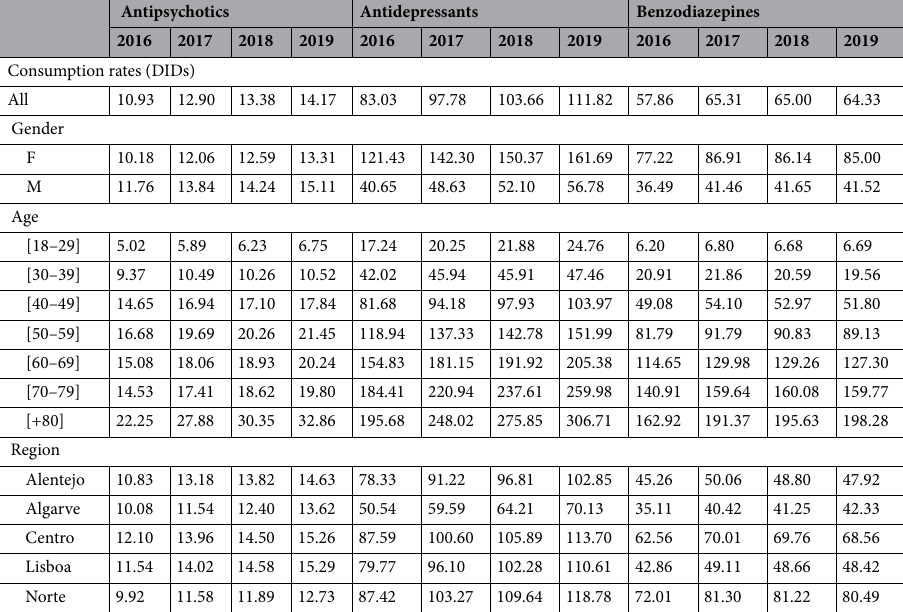
Table 1. Summary of the psychotropic drug consumption status in Portugal: consumption rates across demographic variables expressed in Defined Daily Dose per 1000 inhabitants-days (DIDs).